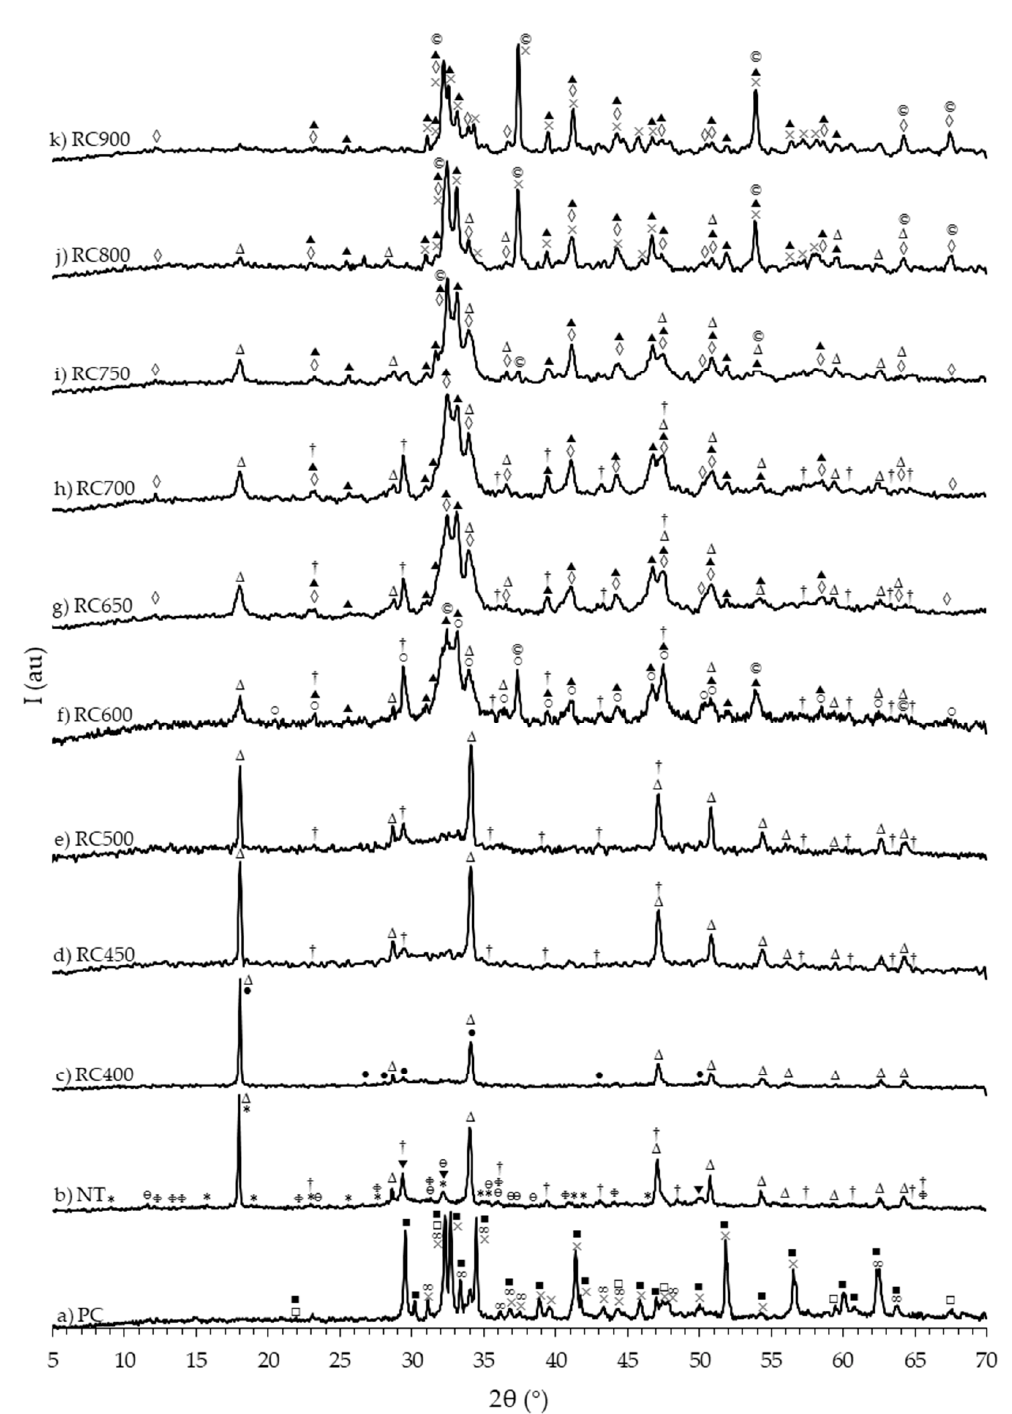
Figure 6. XRD analysis of PC , NT and RC. Δ CH (portlandite); † CaCO 3 (calcite); * AF t (e tt ringite); ∞ (cid:78) α ’ ∞ gypsum; © CaO; (cid:4) C • tobermorite 9Å; (cid:72) C-S-H; × β -C C 3 A (calcium aluminum gypsum; © CaO;  C 3 S; ● tobermorite 9Å;  C-S-H; × β -C 2 S;  α ’ L -C 2 S; ○ C 3 A (calcium aluminum 3 S; 2 S; L -C 2 S; (cid:35) oxide); (cid:3) calcium aluminum iron oxide; ♦ C 4 AF (brownmillerite); Φ alumohydrocalcite; θ calcium oxide); □ calcium aluminum iron oxide; ◊ C 4 AF (brownmillerite); Φ alumohydrocalcite; θ calcium aluminum oxide carbonate aluminum oxide carbonate hydrate.